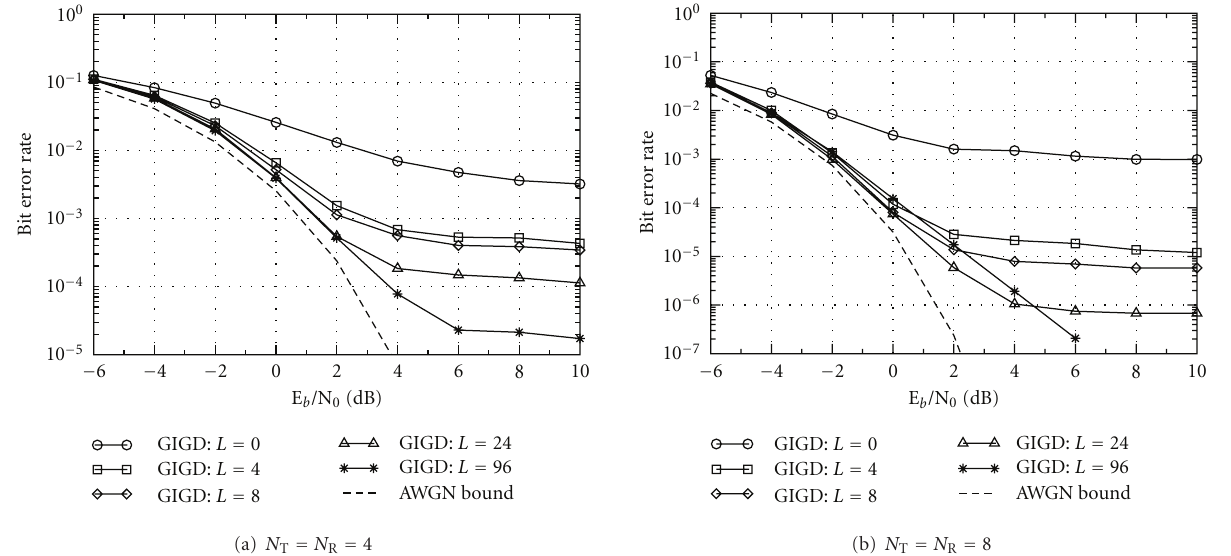
Figure 9: Performance of the GIGD in uncoded systems, K = 400, 5